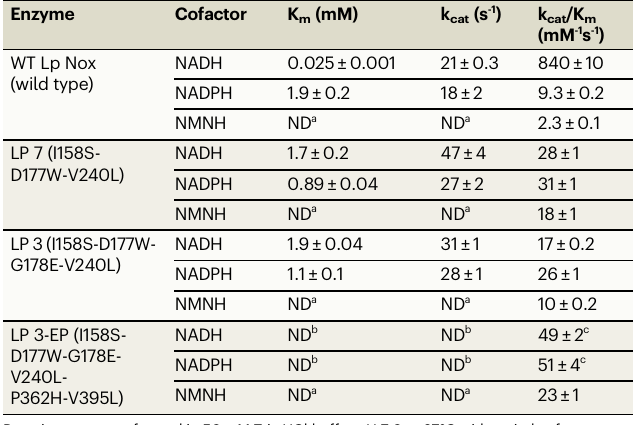
Table 1 | Apparent kinetics parameters of Lp Nox variants